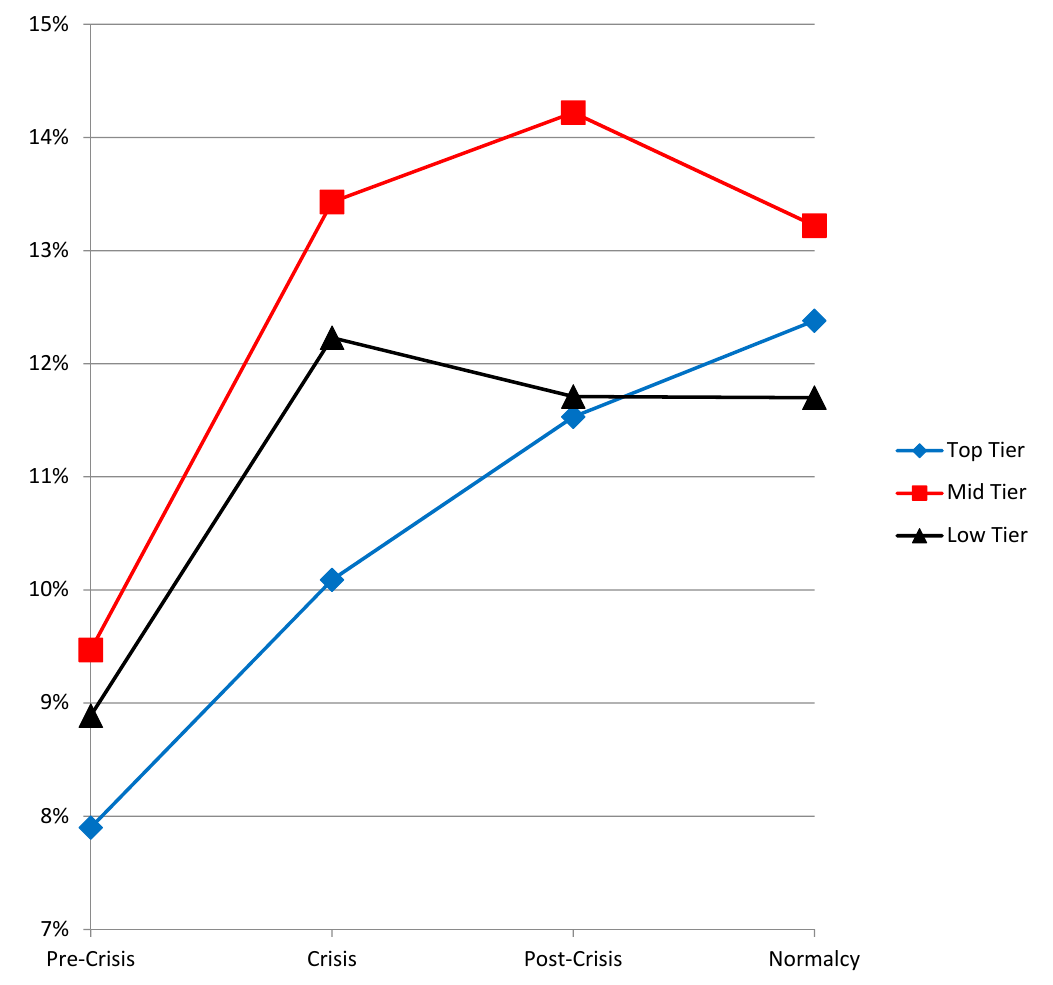
Figure 2. Tier-1 Capital Ratios. Notes: Top-Tier: JPMorgan Chase, Bank of America, Citigroup, and Wells Fargo; Mid-tier: Bank of New York Mellon, State Street, US Bancorp, and PNC Financial Services Group; Low-tier: Capital One Financial, BB&T, SunTrust Banks, and Regions Financial. Pre-crisis: 2005–2007; Crisis: 2008–2010; Post-Crisis: 2011–2013; Normalcy: 2014–2016. Data obtained from published financial reports.